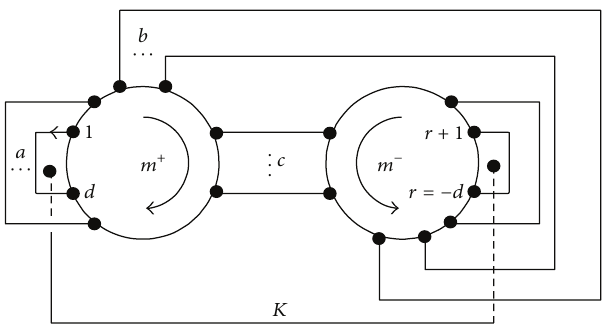
Figure 1: The Dunwoody (1,1) -decomposition 𝐷(𝑎,𝑏, 𝑐, 𝑟) .